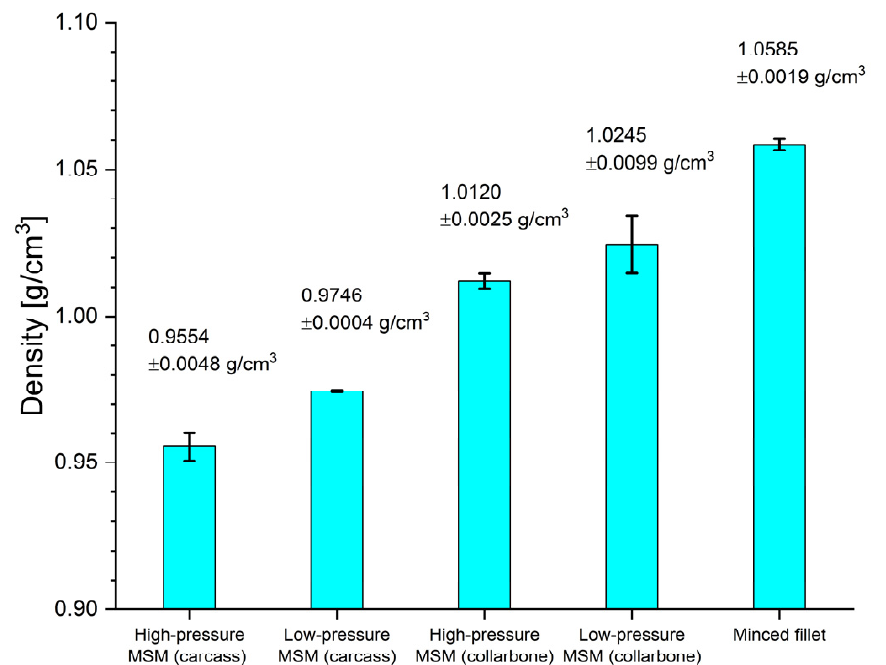
Figure 1. Graph of the mean values of density ρ for different types of MSM with the corresponding confidence intervals: mean value ± standard deviation.